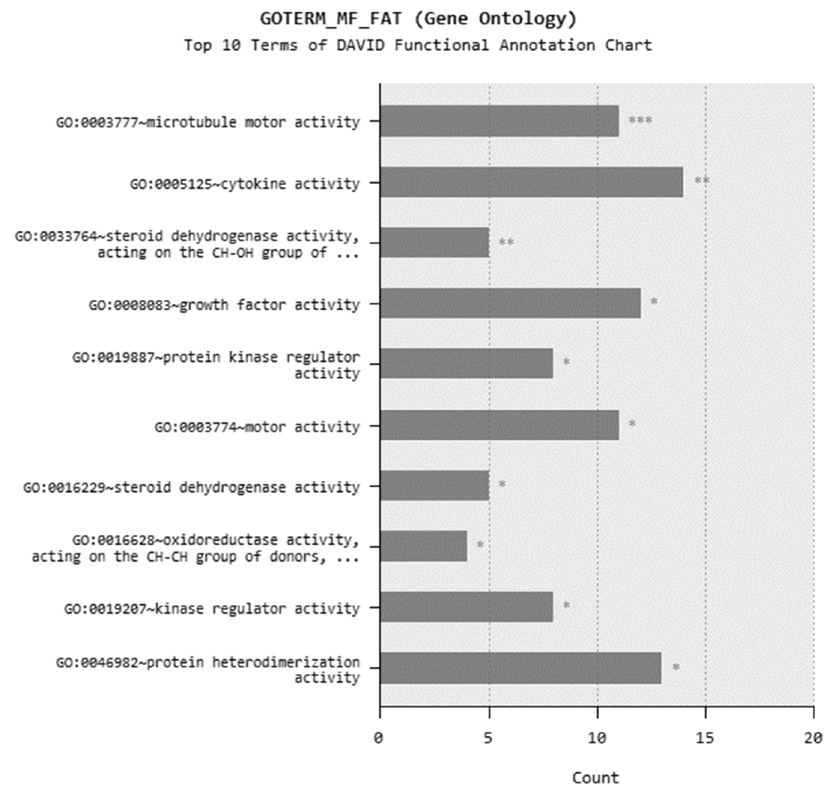
Figure 8. DAVID functional annotation analysis for cobalt boride (Co 2 B) NP application in gene ontology option. p -value < 0.05 (*), p -value < 0.01 (**), and p -value < 0.001 (***).